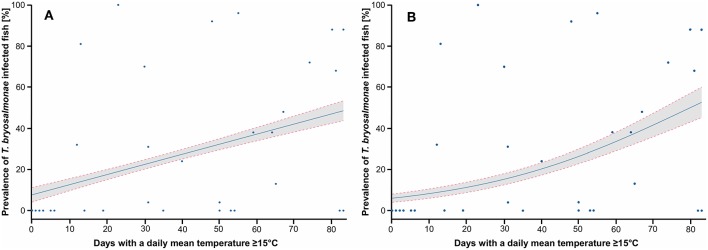
Prediction of the prevalence of T. bryosalmonae infected fish depending on the number of days with a daily mean temperature ≥ 15°C. (A) Prediction of the linear probability model (LPM), R2 is 0.203. (B) Prediction of the logistic model (Logit), Pseudo R2 is 0.309. Blue points correspond to study sites, blue line corresponds to the prediction, gray zone corresponds to the 95% confidence intervals.